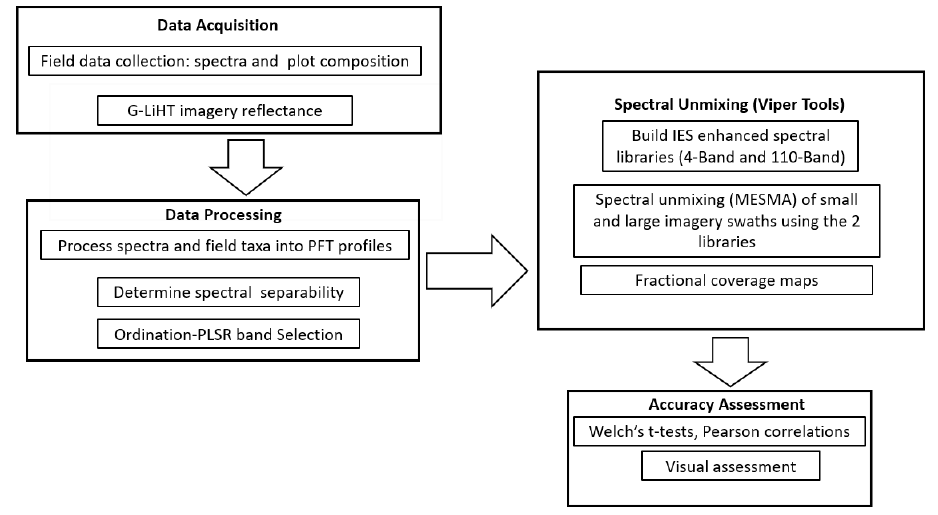
Figure 3. Synoptic workflow illustrates the four main procedural steps: Data Acquisition, Data Processing, Spectral Unmixing, Accuracy